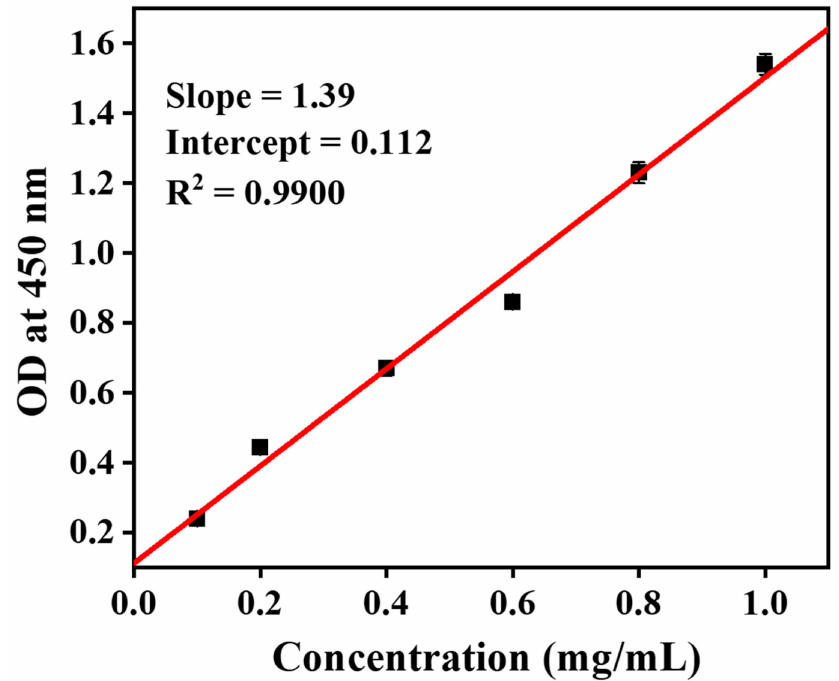
Figure 6. Standard curve of serum Tf levels estimated using